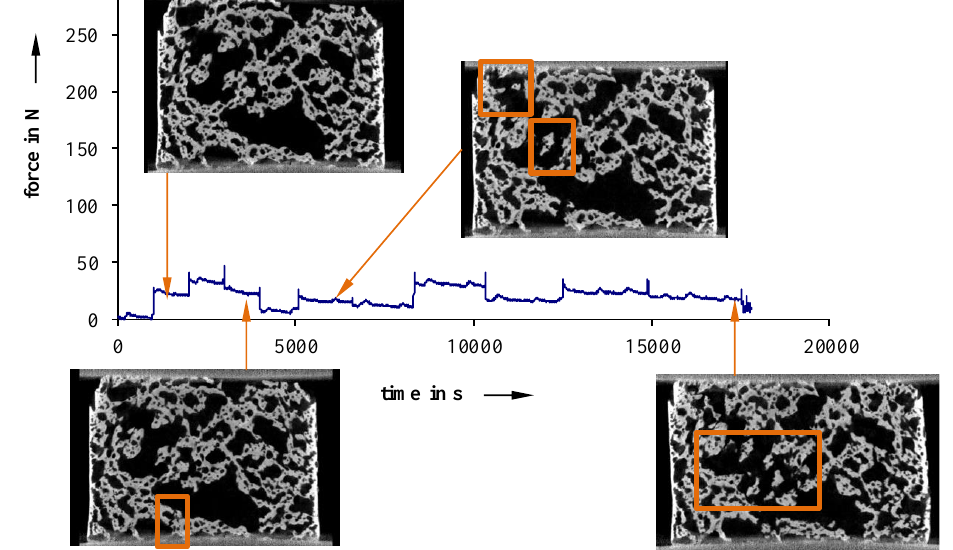
Figure 13. Recorded force-travel curves of compression tests conducted on an in situ µCT; 40 °C. For more inhomogeneous samples, material failure starts to occur between 25 N (40 °C) and 50 N (23 °C) (Figures 12 and 13). The density of fractures constantly rises, with increasing deformation, until a partial structure failure develops at relatively low load levels of 50 N (40 °C) and 110 N (23 °C not devolatilized). On the other hand, more homogeneous foam structures show a maximum load up to 200 N, even after the first signs of material failure (Figure 11). Detailed examinations show that especially cracks on the surface lead to material failure. This is a sign of an uneven sample surface, and results in a non-uniform load.